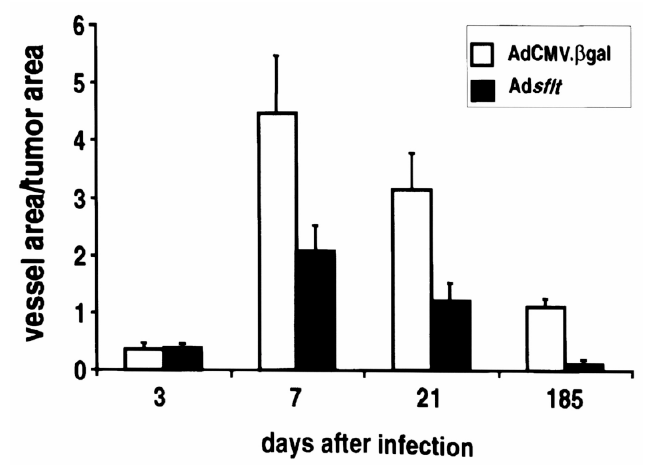
Figure 5. Adsflt induces blood vessel regression in vivo . To determine whether Ad sflt could inhibit tumor vascularization, the blood vessel area/tumor area ratio was evaluated on Masson trichrome- stained tumor tissue sections using a KS300 imaging system. No significant difference was observed at 3 days, but after 7 days, the tumors treated with Ad sflt showed a steady decrease in their vessel area/tumor area ratio ( p = 0.0199). Six months after treatment (185 days), there was a 9.5-fold decrease in tumor vascular density in Ad sflt - compared to AdCMV.bgal-infected tumors ( p < 0.0001). Graph shows mean values of vessel area/tumor area ± SE ( n = 9 per condition and time point) ( p < 0.05).